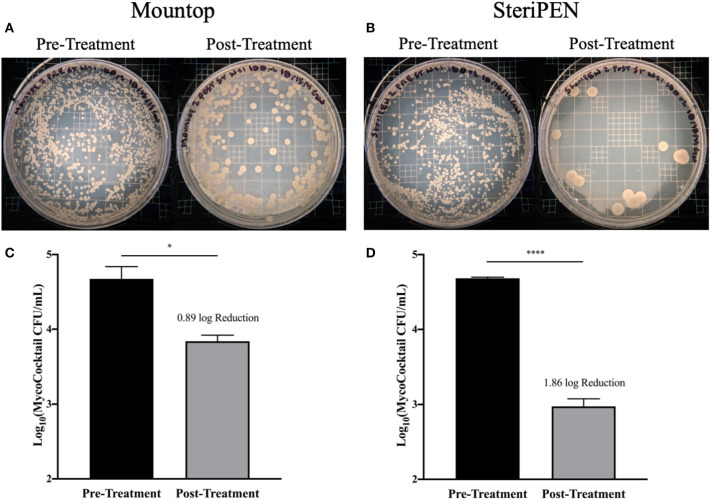
NTM CFU is significantly reduced after single UV treatment in both and Mountop and SteriPEN systems. Mountop (A,C) and SteriPEN (B,D) systems were inoculated with MycoCocktail and immediately UV-C disinfected per the manufacturer's protocol. (A,B) Representative images of MycoCocktail CFU in Mountop and SteriPEN before and after UV treatment. (C,D) Log(MycoCocktail CFU) before (pretreatment) and after (post-treatment) UV disinfection. n = 3 independent CFU measurements per time point. ns, not significant; significant at *p < 0.05, ****p < 0.0001.